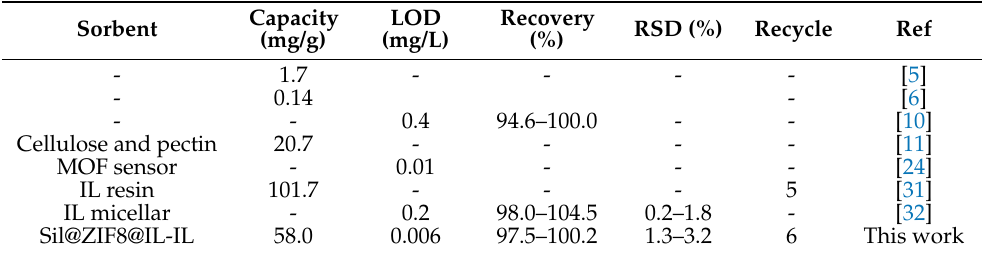
Table 2. Comparison of the methods or proposed material for